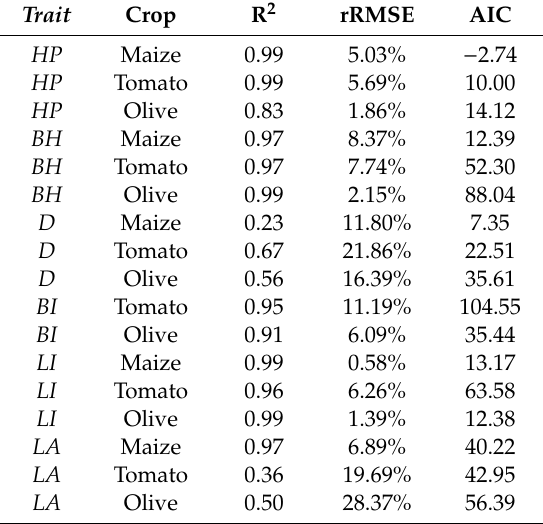
Table 1. Statistical tests (R 2 and rRMSE) and goodness-of-fit (AIC) for plant height ( HP ), branches height ( BH ), merged basal, half-plant and apical stem diameters ( D ), petioles / branches inclination ( BI ), leaf inclination ( LI ) and leaf area ( LA ) extracted from maize, tomato and olive tree 3D models using 90 images at 4.88 µ m / pixel